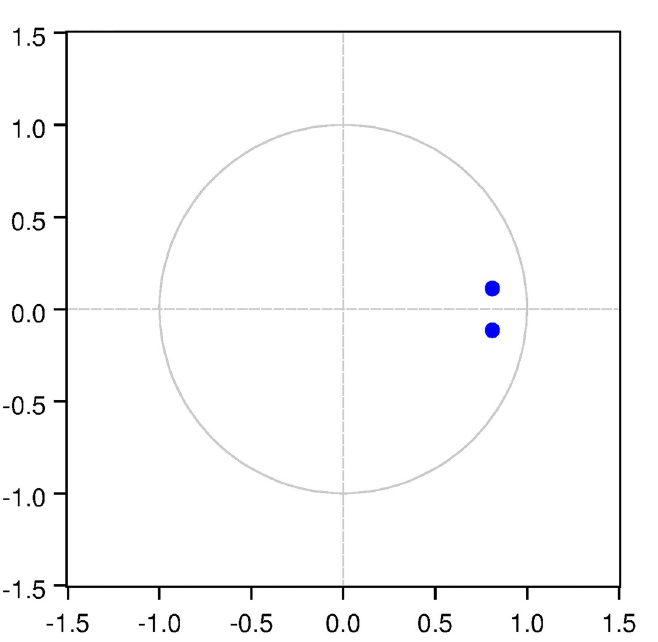
Fig 10. Inverse roots of AR characteristic polynomial for Australian data when P = 1 (fisherian